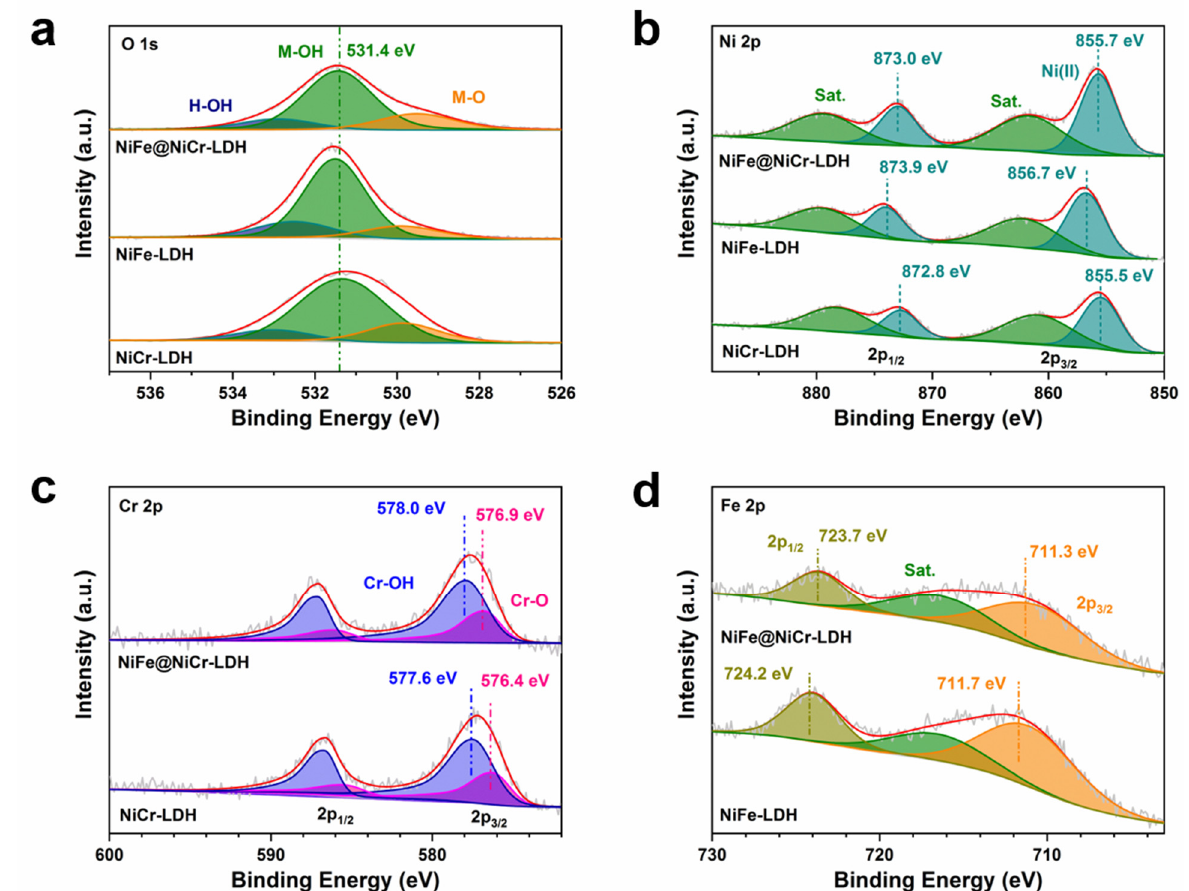
Figure 3. High-resolution XPS spectra of the ( a ) O 1s, ( b ) Ni 2p, ( c ) Cr 2p, and ( d ) Fe 2p electrons in NiFe@NiCr-LDH, NiCr-LDH, and NiFe-LDH.